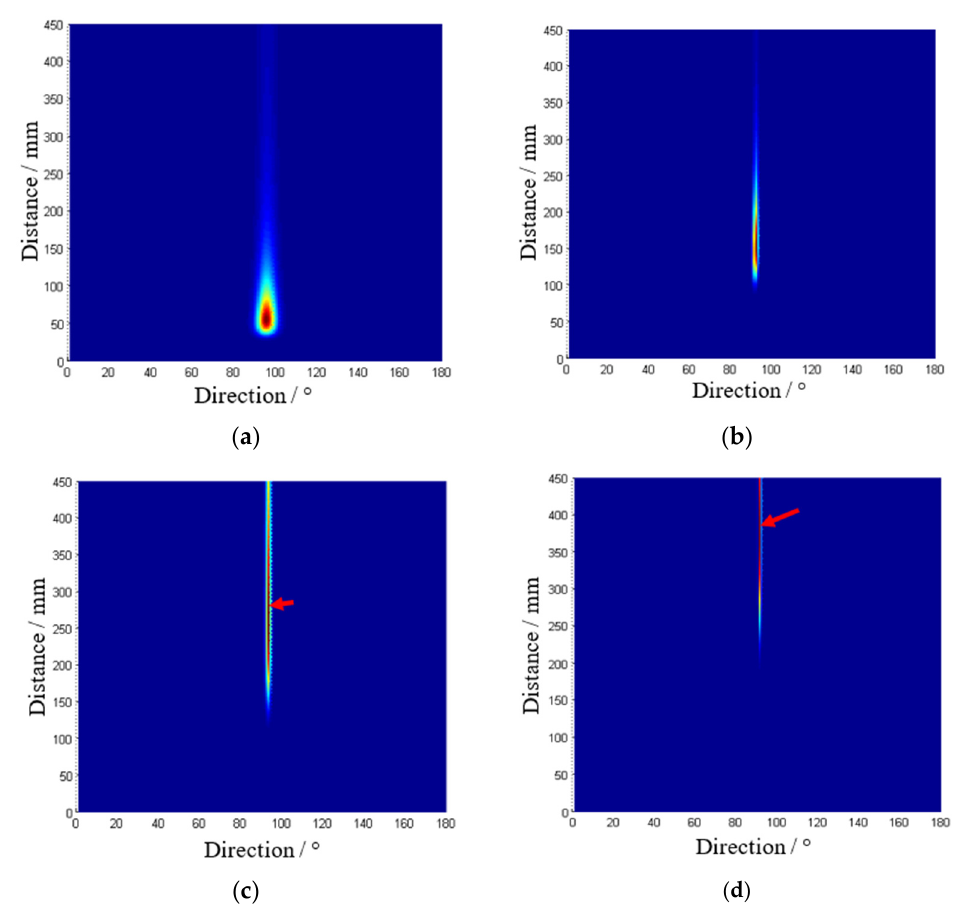
Figure 10. The spatial spectrums estimated by the 2D-MUSIC algorithm. ( a ) No. 3; ( b ) No. 13; ( c ) No. 23; ( d ) No. 38